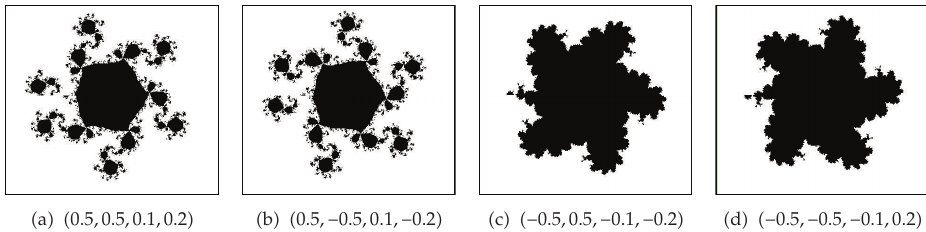
Figure 9: The generalized J sets perturbed by additive noise when α (cid:6) 5 . 5, θ ∈ (cid:7) − π,π (cid:4)